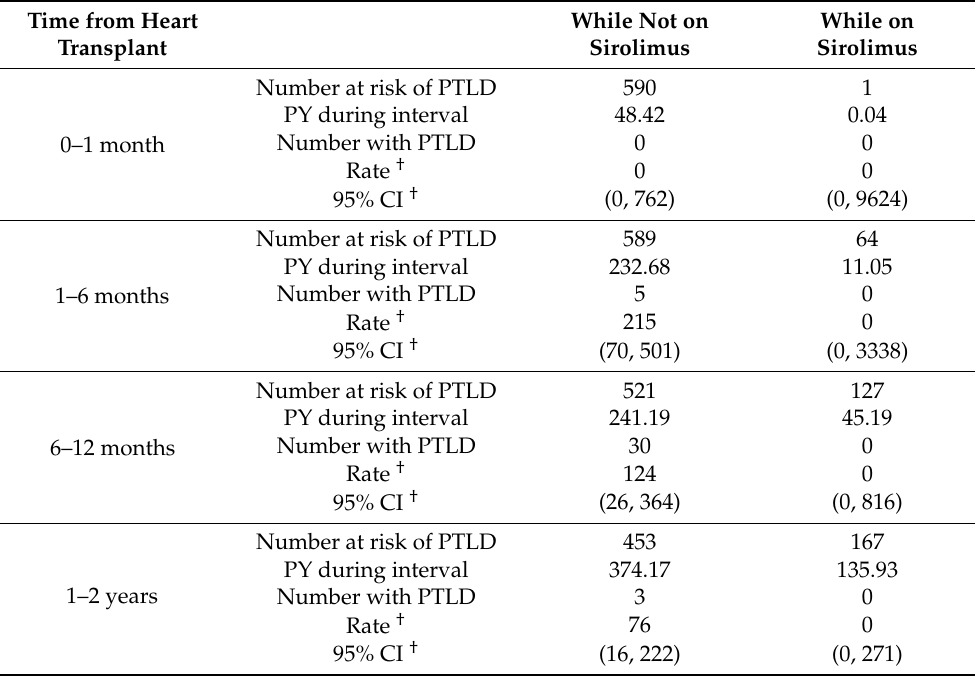
Table 4. Rate of PTLD per 10,000 person years, categorized by Sirolimus treatment. Time from Heart